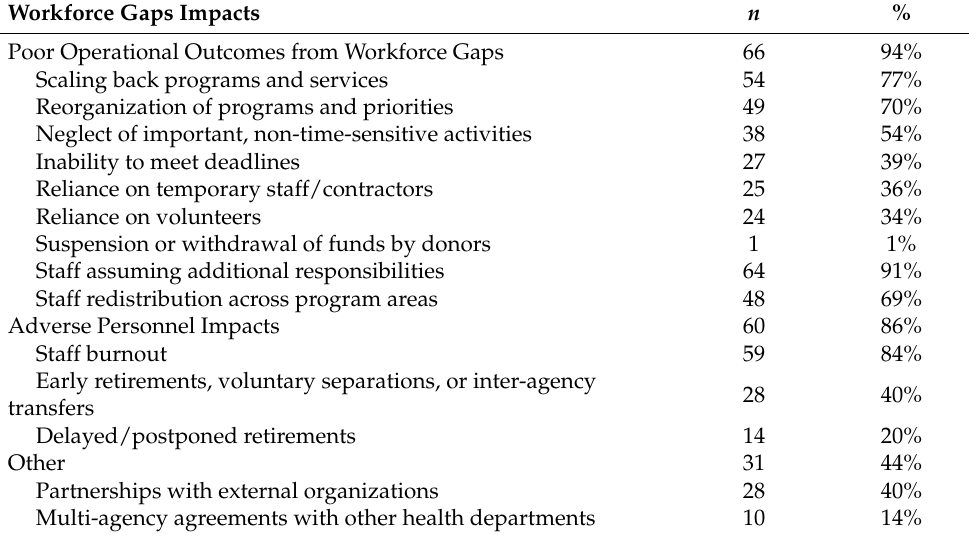
Table 3. Workforce gaps impacts experienced by survey respondents’ agencies sorted by focus group themes. ( n =